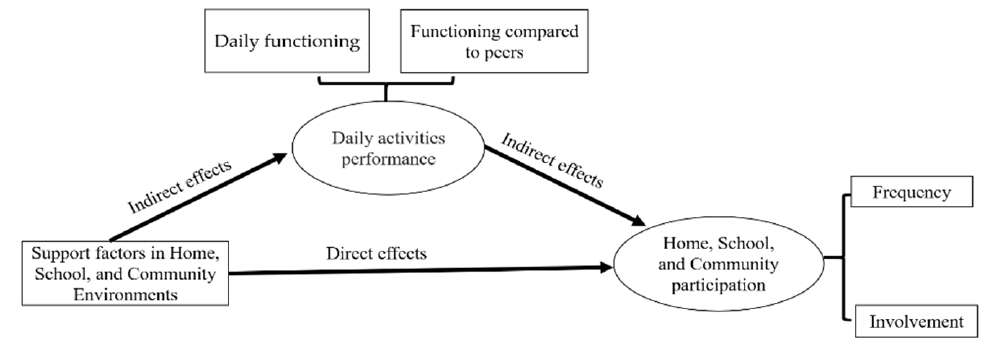
Figure 1. Conceptual model.